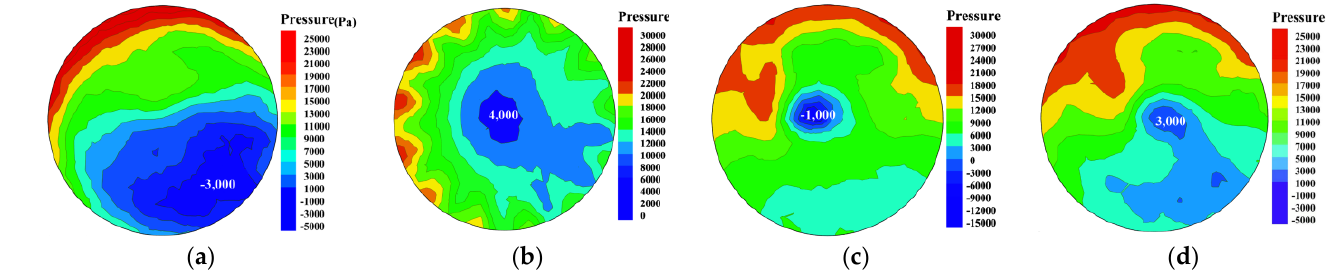
Figure 12. Pressure contours on TP1 surface of draft tube. ( a ) Q* = 53%(N−J), ( b ) Q* = 69% (W−J), ( c ) Q* = 82%(N−J), ( d ) Q* = 100% (W−J).